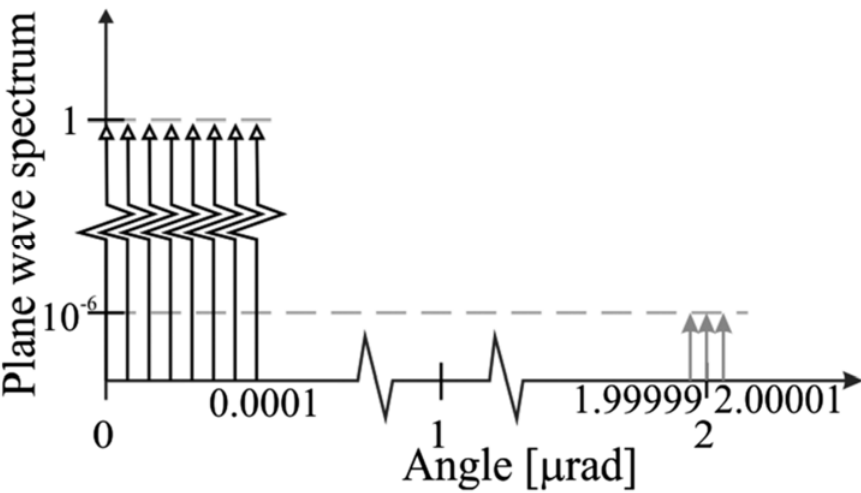
Figure 5. A solar system, that includes a Sun-like star and a Jupiter-like planet at 10 parsecs, subtends an angle of 2 µ rad at the Earth. At that distance, the star and the planet subtend an angular radius of 10 − 4 and 10 − 5 µ rad at the Earth. Due to the resolution limitations of the available telescopes, both the planet and the star are unresolved, or point,